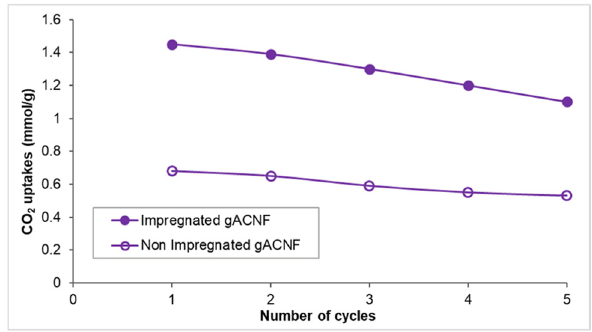
Figure 11: Cyclic ability of the CO 2 adsorption on PEI - impregnated and nonimpregnated GRHC/ACNFs at 50°C and 1